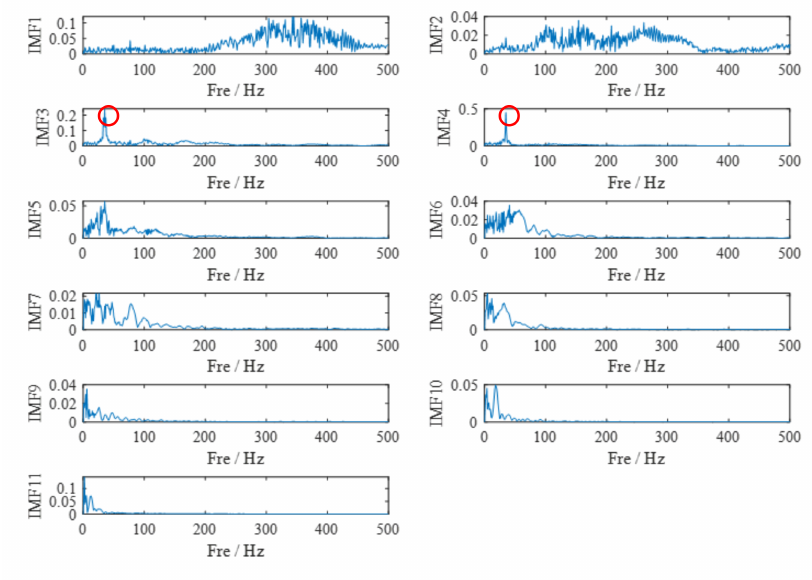
Figure 6. Performance of signal decomposition by Empirical Mode Decomposition